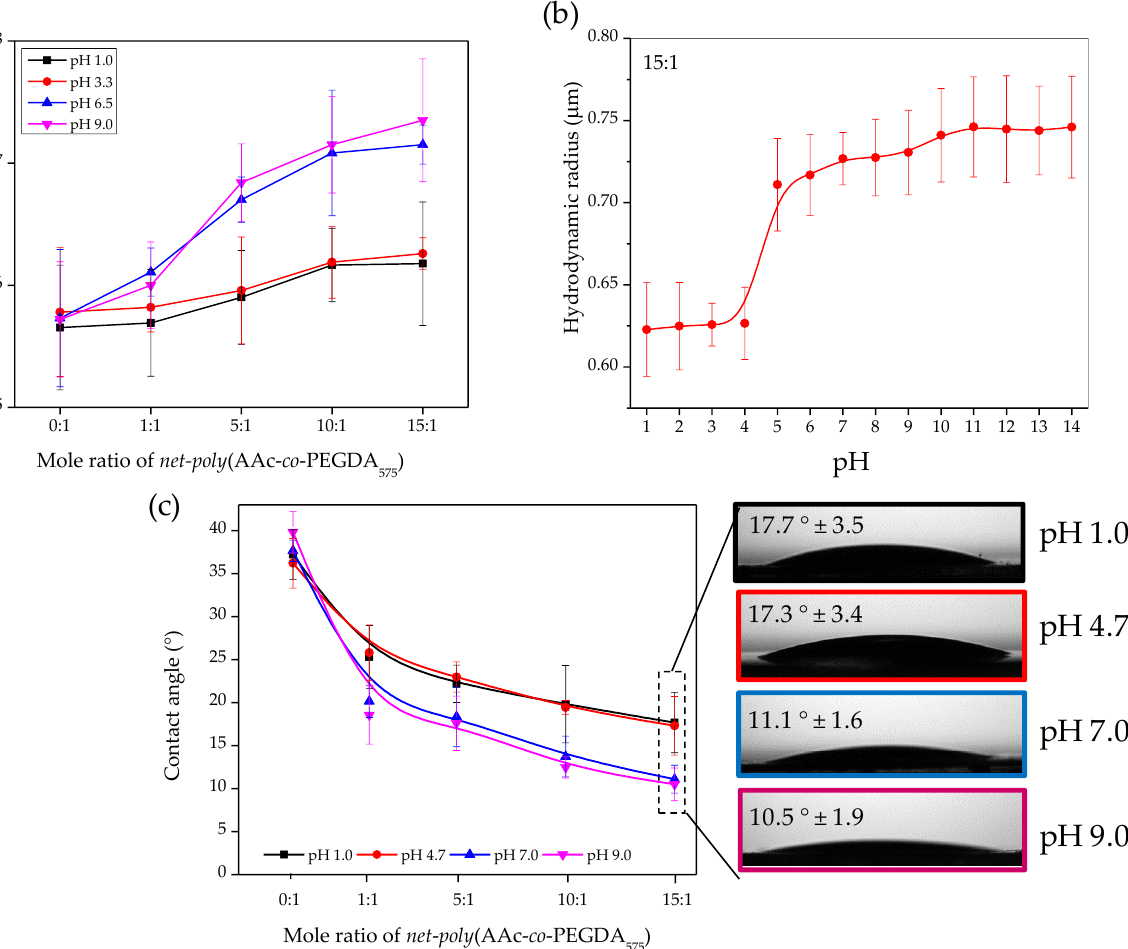
Figure 6. ( a ) Dependence of the hydrodynamic radius at four different pHs (1.0, 3.3, 6.5, and 9.0) for the samples poly (AAc- co -PEGDA 575 ), ( b ) DLS-Titration curve of the for the sample 15:1 using several pHs as analysis medium, and ( c ) contact angle of a small drop on the hydrogel surface with different pH, together with some representative images. According to the results obtained via DLS analysis, the samples 10:1 and 15:1 pre- sented the larger changes with the pH. These two were selected to address the hydrogel films’ physical changes when exposed to different pH mediums using QCM and ellipso-